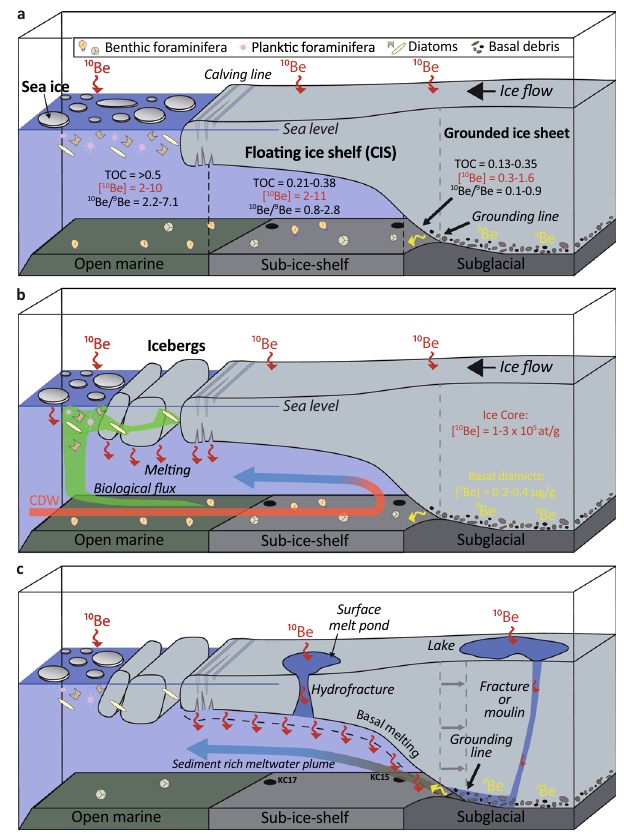
Fig. 4 Illustration of the potential processes in fl uencing Be isotopes within Ferrero Bay. a Open marine, sub-ice-shelf, and subglacial environments are de fi ned by different geochemical compositions 27,34 . b Melting of icebergs and sea ice near the calving line releases 10 Be which is rapidly scavenged by diatom frustules and organic matter before becoming advected under the ice-shelf with other marine material by ocean currents such as intruding CDW. c Meltwater rich in 10 Be is released from the ice-shelf base and scavenged by fi ne-grained sediment delivered from the grounding line. This fi gure was modi fi ed from Yokoyama et al. 24 and White et al. 27